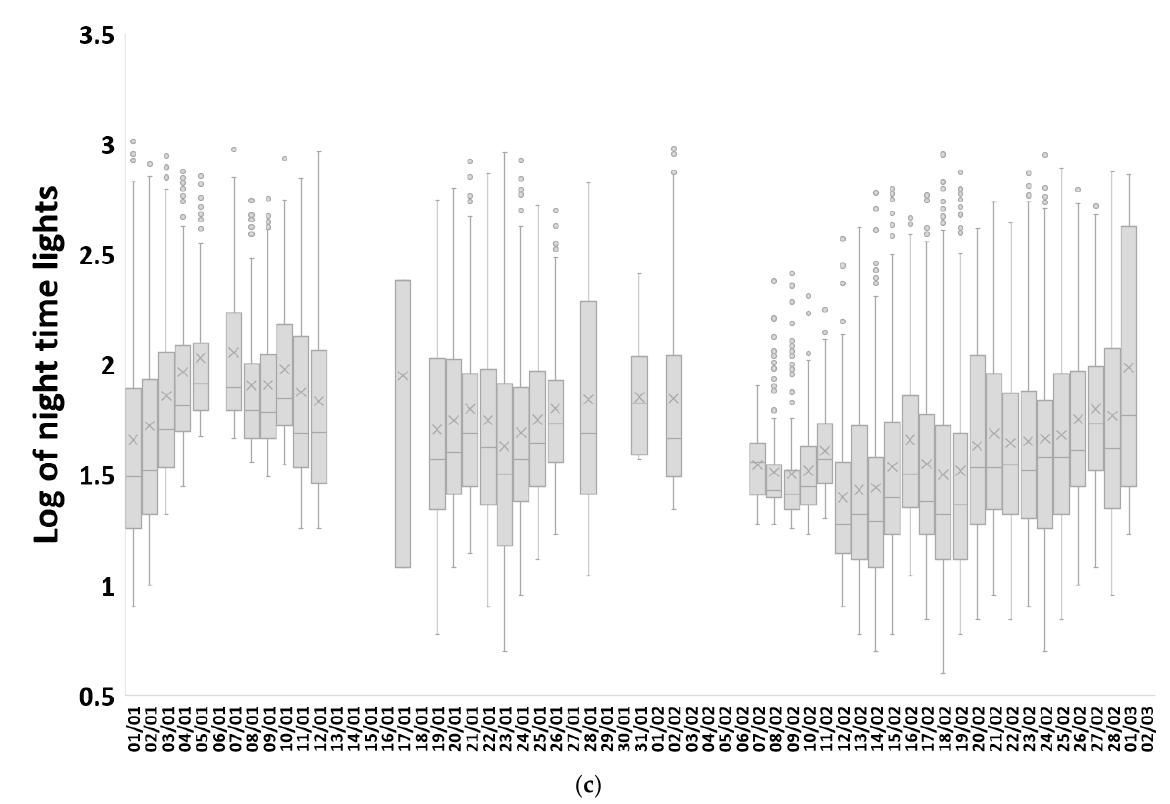
Figure 8. Time series of box plots of nighttime lights for lit grid cells within three regions that experienced a statistically significant decrease in NTL values between the period before the earthquakes (1 January–5 February, 36 days) and the period after the earthquakes (7–14 February, 14 days): ( a ) Antakya (Hatay-Merkez), ( b ) Hatay-Samanda, ( c ) Hathay-Kirkhan. Dates with no boxplots had no cloud-free pixels.